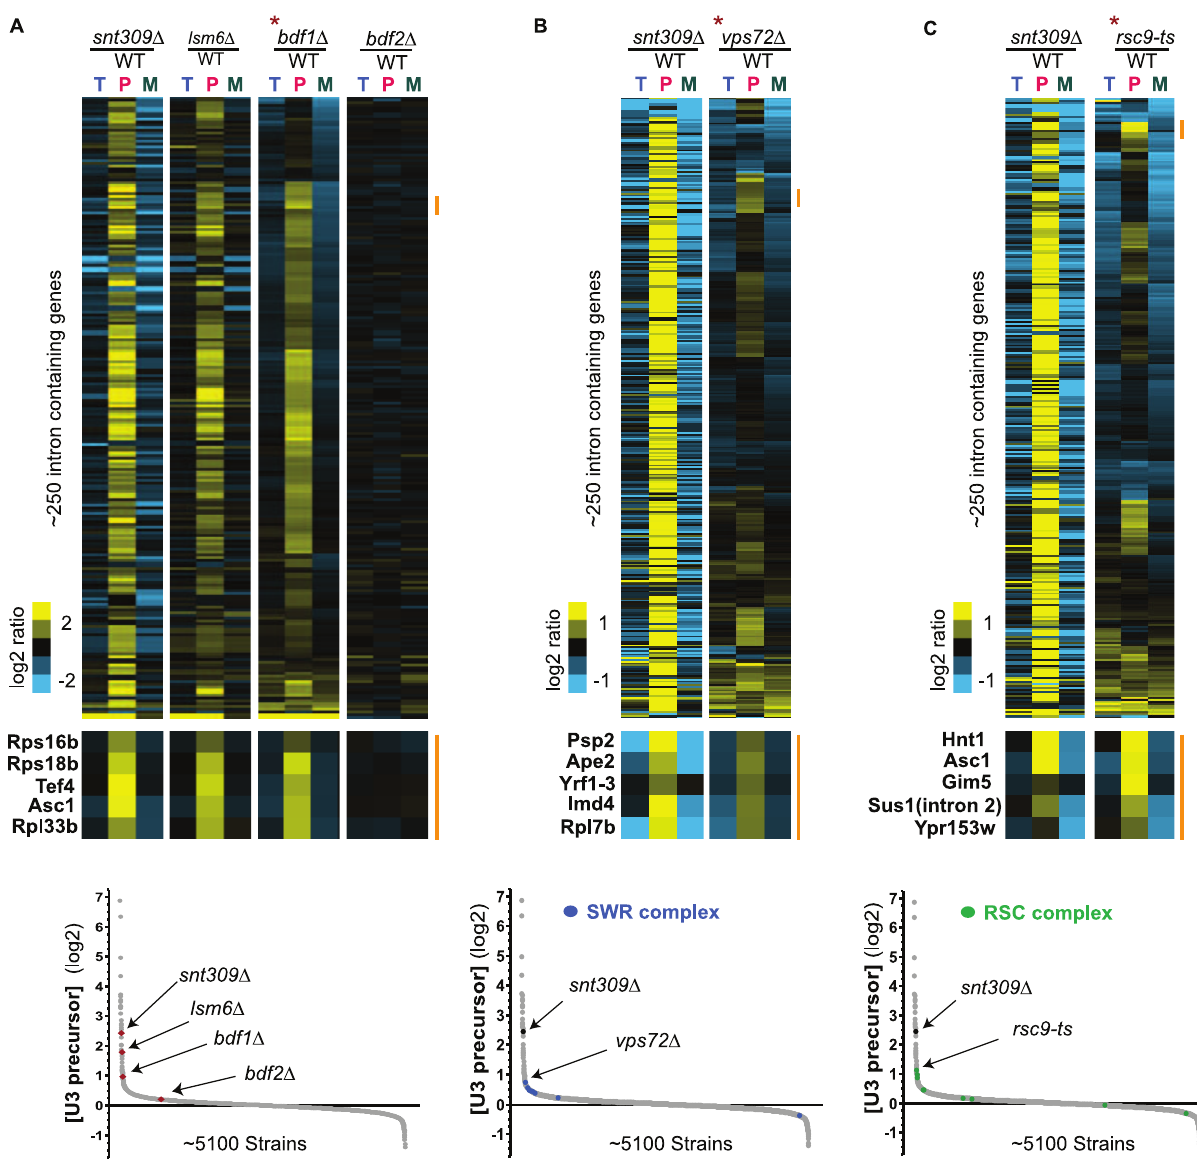
Figure 5. Mutations in chromatin remodeling factors can impact splicing in a global or transcript-specific manner. Splicing sensitive microarrays of candidate factors (A) bdf1 D and bdf2 D , (B) vps72 D , and (C) rsc9-ts , as compared to the phenotypes of known splicing mutants snt309 D and lsm6 D . For each panel, the asterisk indicates the strain by which the data have been organized using hierarchical clustering, with the other data sets in those panels sharing an identical gene ordering. The orange bar highlights the location of specific subsets of transcripts showing splicing defects. The bottom insets show the location of each of the candidates within the U3 precursor dataset. Also, the locations of each of the components of the SWR complex are shown in blue, and each of the components of the RSC complex are shown in